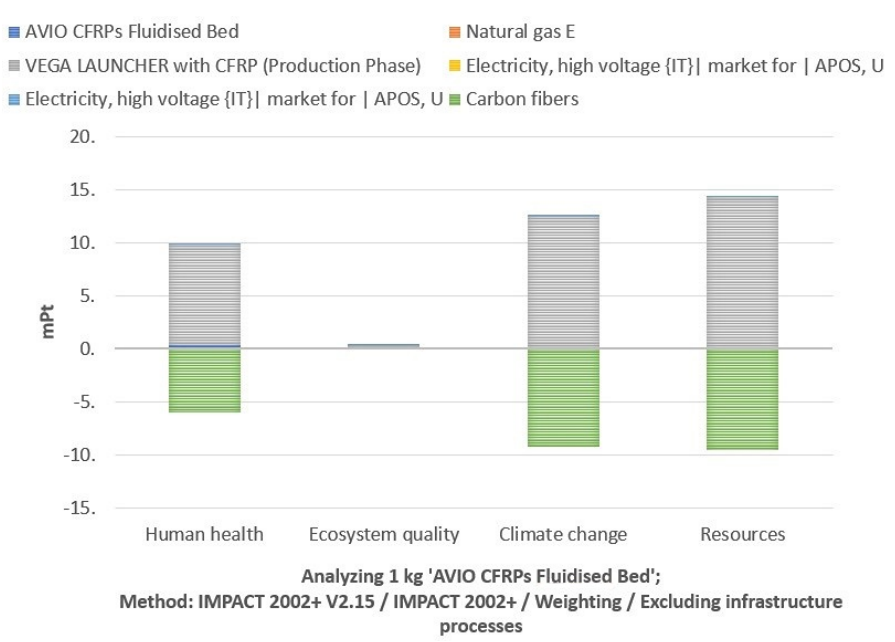
Figure 22. Results of Fluidized Bed recycling into endpoint categories.